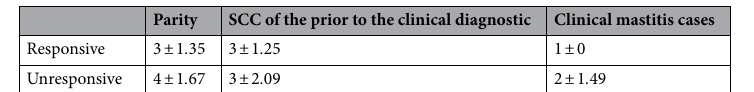
Parity SCC of the prior to the clinical diagnostic Clinical mastitis